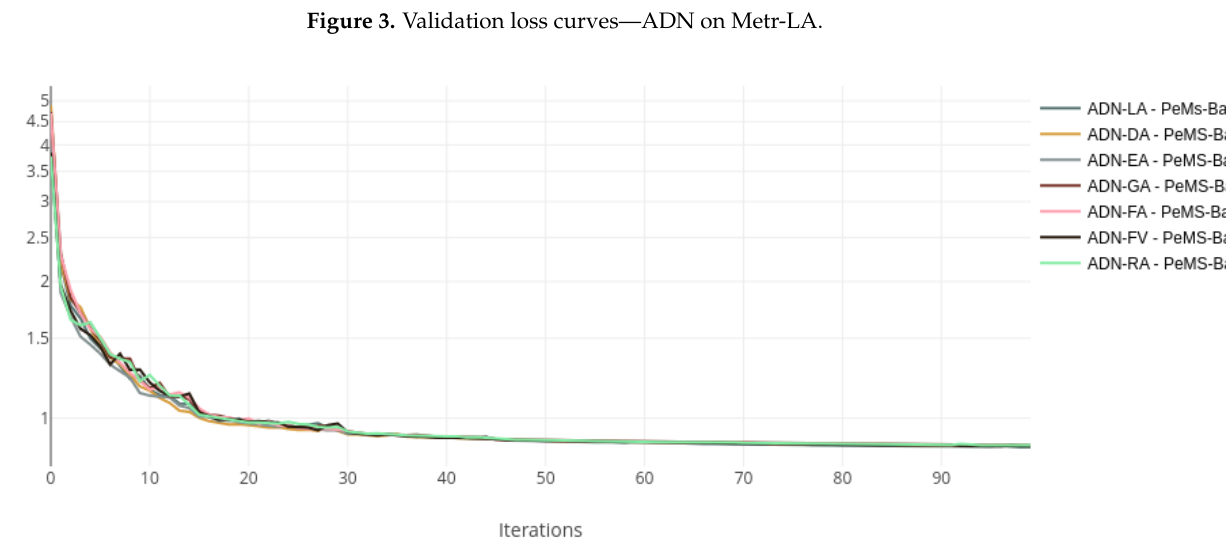
Figure 4. Training loss curves, log scale—ADN on PeMS-Bay.